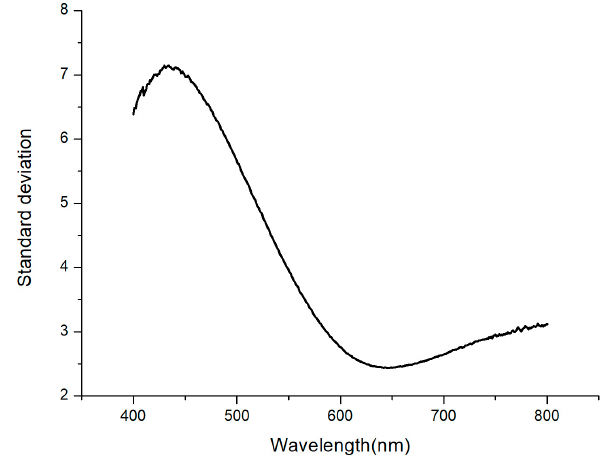
Figure 4. The standard deviation curve of the reflectivity change of all cells at different wavelengths.